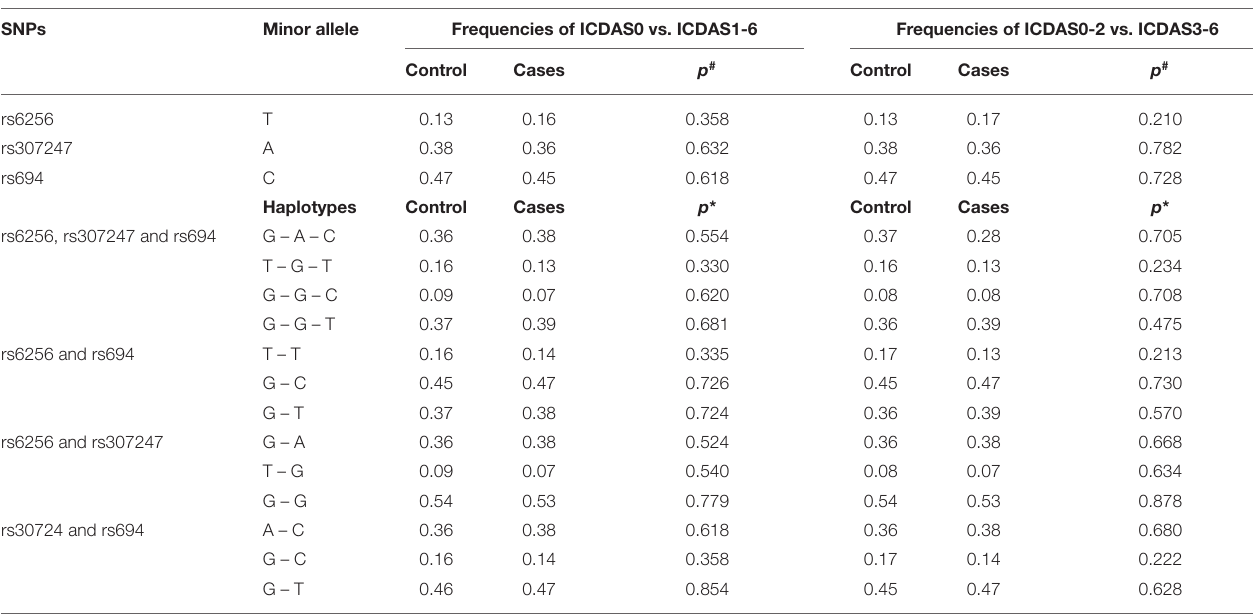
TABLE 3 | Allele and haplotype analysis. SNPs Minor allele